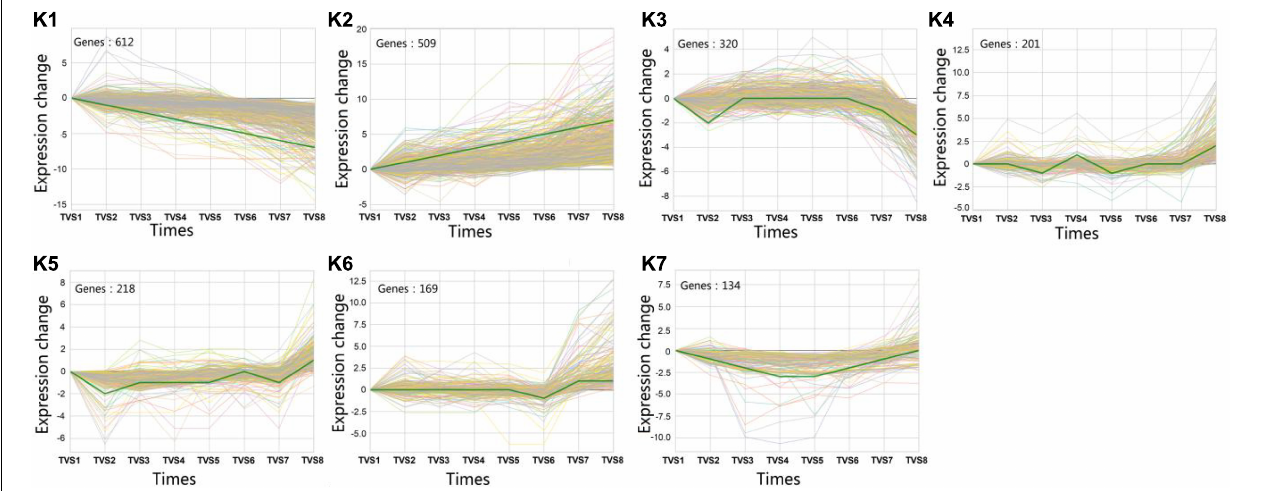
FIGURE 5 | Series test of cluster (STC) analysis of DEGs between adjacent time points. STC analysis showing gene expression profiles. Seven clusters (K1-K7) were identified based on expression levels in 8 time points (TVS1, TVS2, TVS3, TVS4, TVS5, TVS6, TVS7, and